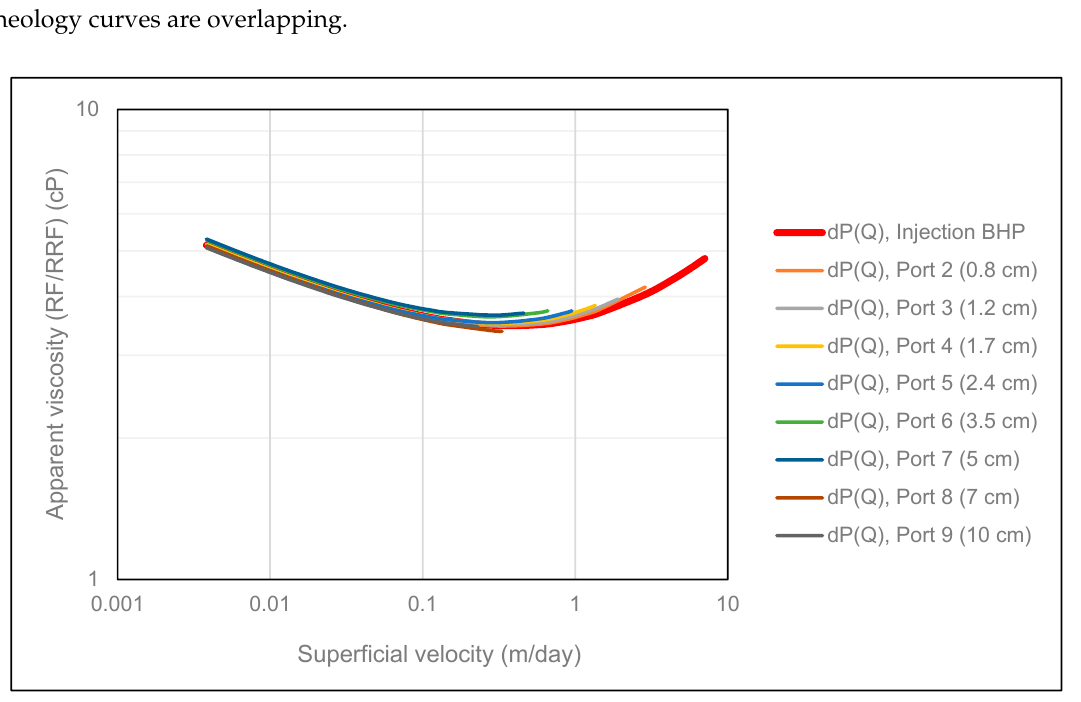
Figure 7. Polymer in situ rheology obtained using the SPMM.